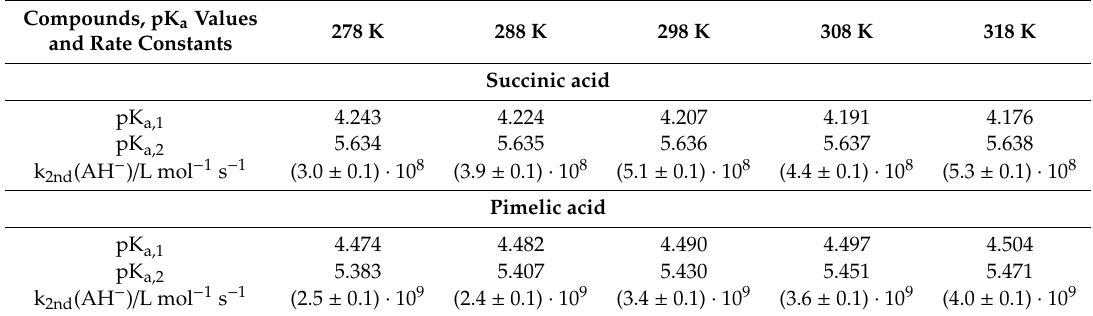
Table 2. Calculated pK a values and radical rate constants of the monoanionic dicarboxylic acids AH − 131 at different temperatures. 132 Compounds, pK a values and rate constants